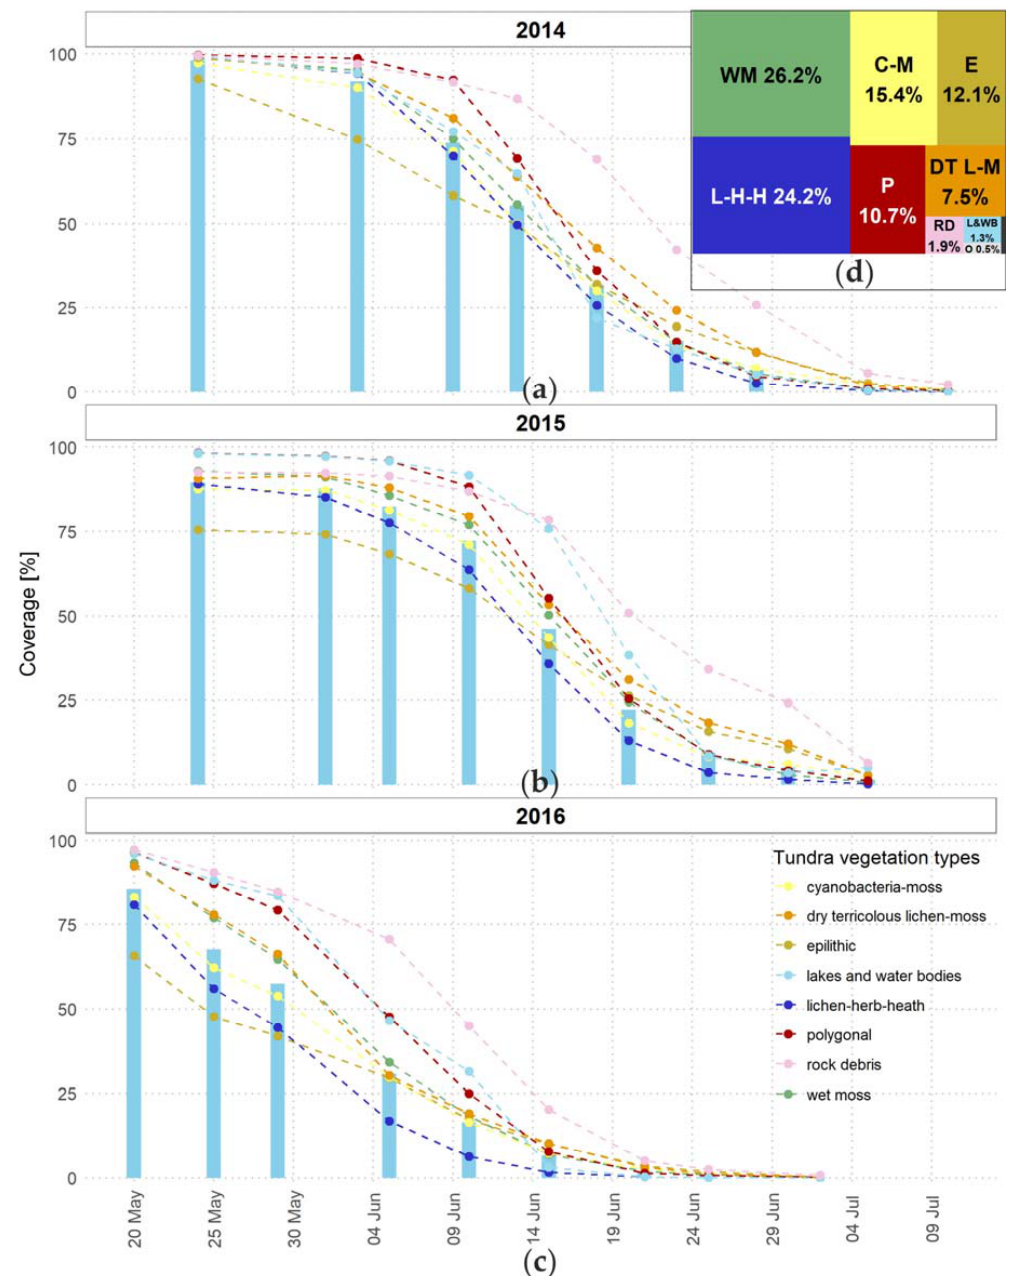
Figure 9. Evolution of snow coverage on various types of land cover in Fuglebekken catchment at approximately 5 day intervals in spring: ( a ) 2014, ( b ) 2015 and ( c ) 2016. Blue bars represent SCE in the whole study area. ( d ) The share of individual land cover types in the study area. Two tundra vegetation types covering the lowest percentage of study area were omitted in spatial analysis: ornitocoprophilus (O) tundra (0.5%) and geophytic initial (GI) tundra (0.2%). Table 5. Statistically significant ( p value < 0.05) mutual relations between snow depth on different land cover types. The analysis was performed for the whole period 2014–2016 with date as covariate Statistically significant differences in the ANOVA test were found between SCE, snow depth (after excluding outlier values at the foothill of Fugleberget Mountain). and SWE measured on various tundra types, although post-hoc analysis with the Tukey HSD test suggest significant differences only between some of the tundra communities. For snow depth,